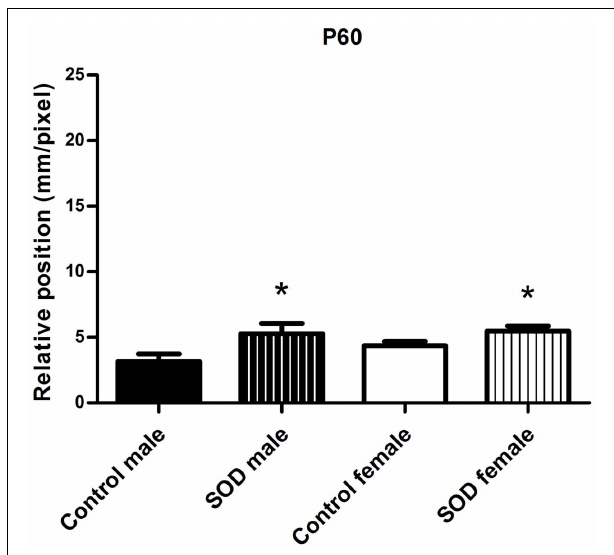
FIGURE A1 | Locomotor function analysis of hSOD1 G93A female and male mice. CatWalk gait analysis. Graph represent the distance between the front and hind paws on a step sequence (“relative position”) of control males ( n = 16), hSOD1 G93A males ( n = 11), control females ( n = 32) and